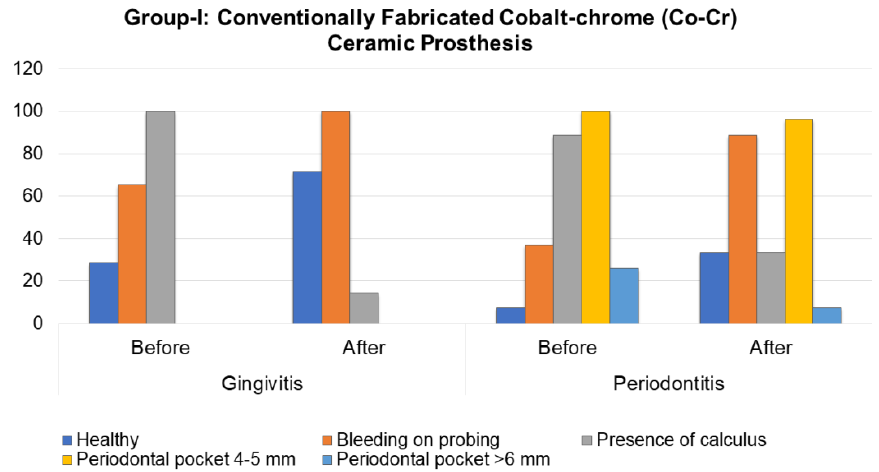
Figure 1. Periodontal status before and after the prosthetic rehabilitation in Group-I patients. Inflammatory processes were found in this group in patients with periodontitis with bleeding while brushing, bad breath, hypersensitivity to temperature changes, and presence of hard dental plaque that could not be removed by brushing. The clinical examination revealed signs of congestive hyperemia of the gingival papillae and exposure of tooth necks up to one fourth of the root length. Periodontal pockets were found with an average number of segments of 2.3 ± 1.07 ( p < 0.01) per patient examined with this symptom. With age, the percentage of people with clinical gingival pockets of 6 mm or more increased, as well as the average number of affected segments 0.37 ± 0.69 ( p < 0.01) per patient exam- ined. After the prosthetic rehabilitation, a decrease in the signs of periodontal lesions was observed. The mean percentage of sextants with plaque was 33.3%, with an intensity of 0.44 ± 0.75 ( p < 0.01); sextants with a pocket of 4-5 mm amounted to 96.3%, with an inten- sity of 1.52 ± 0.75 ( p < 0.01); and sextants with a pocket of 6 mm or more amounted to 7.4%, with an average intensity of 0.11 ± 0.4. This resulted in a significant increase in the number of healthy and bleeding sextants, with a mean percentage of 33.3% with an intensity of 0.59 ±1.1 and 88.9% with an intensity of 2.33 ± 1.4 ( p < 0.01), respectively.